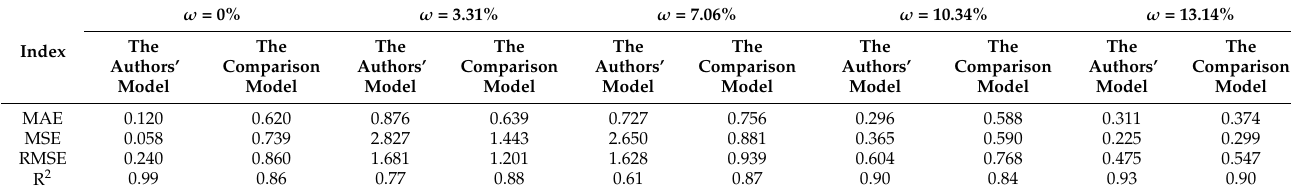
Table 5. The fitting effect evaluation index values of the two models based on the experimental data in test group